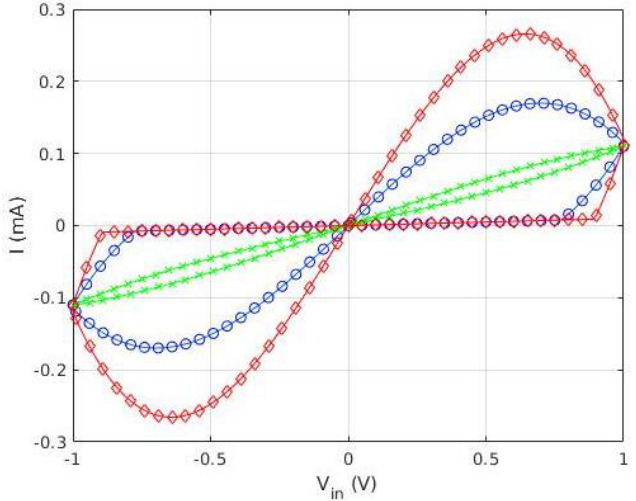
Figure 2. Representation of the I-V characteristics of the memristor defined by Equations (1) and (6) for G 0 = 0.1 mS, φ 0 = 10, and three different frequencies ( ω (red (cid:5) ) < ω (blue o) < ω (green